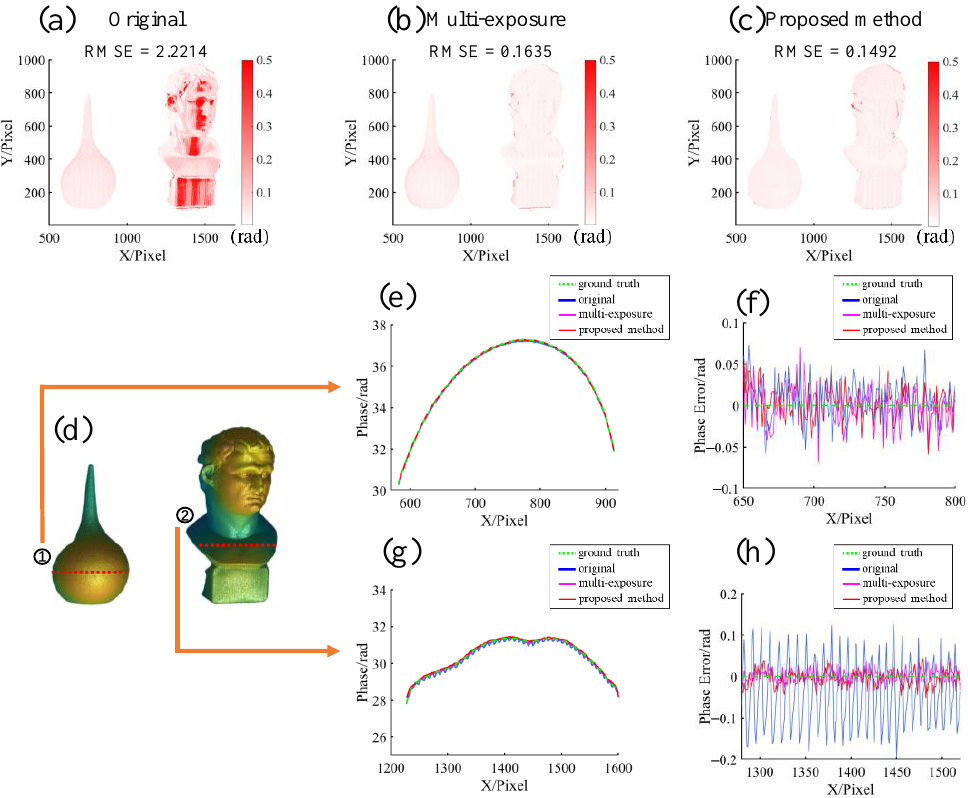
Figure 10. Error comparison of different methods. ( a ) Phase error directly from saturated fringes. ( b ) Phase error of multiexposure method. ( c ) Phase error of the proposed method. ( d ) Sampling positions of section lines. Panels ( e , f ) are the phase and error comparisons of different methods at sampling position 1, respectively. Panels ( g , h ) are the phase and error comparisons of different methods at sampling position 2, respectively.